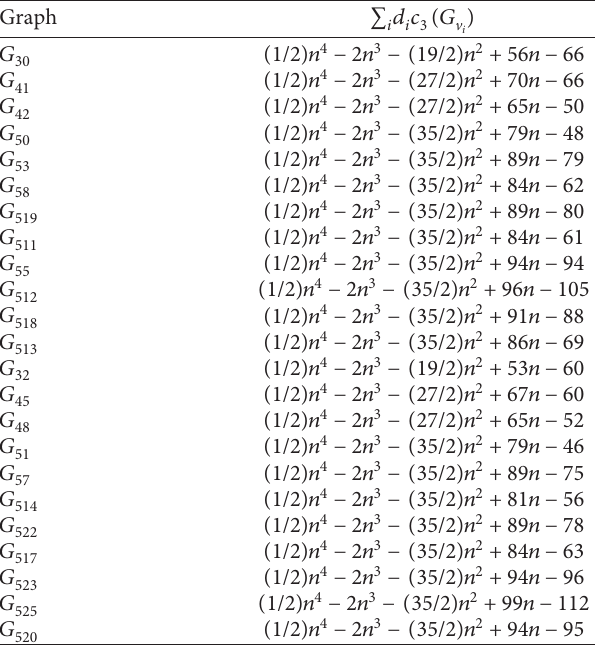
d c ( G ) of some graphs in G i i v i 3